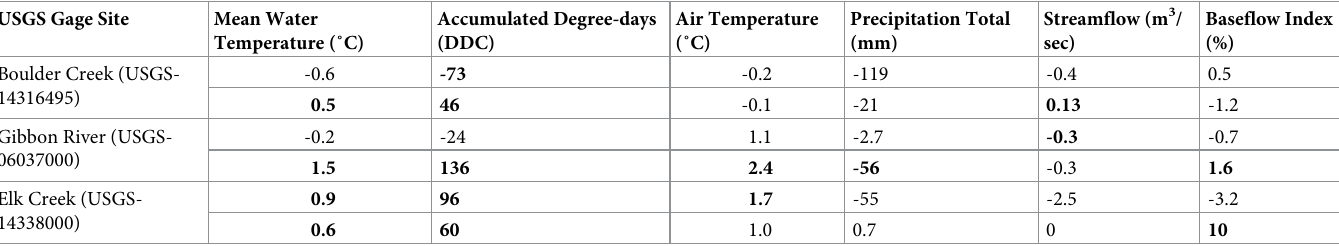
Table 2. Median differences between the pre- and post-fire winter (December-February; upper lines) and summer (July-September; bottom lines) weather, water temperature, and flow conditions. Bold text represents statistically significant change ( p < 0.05). USGS Gage